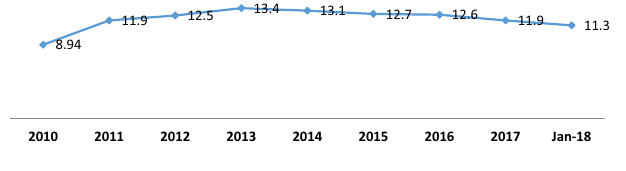
Figure 7. Total unemployment rate in Egypt during the